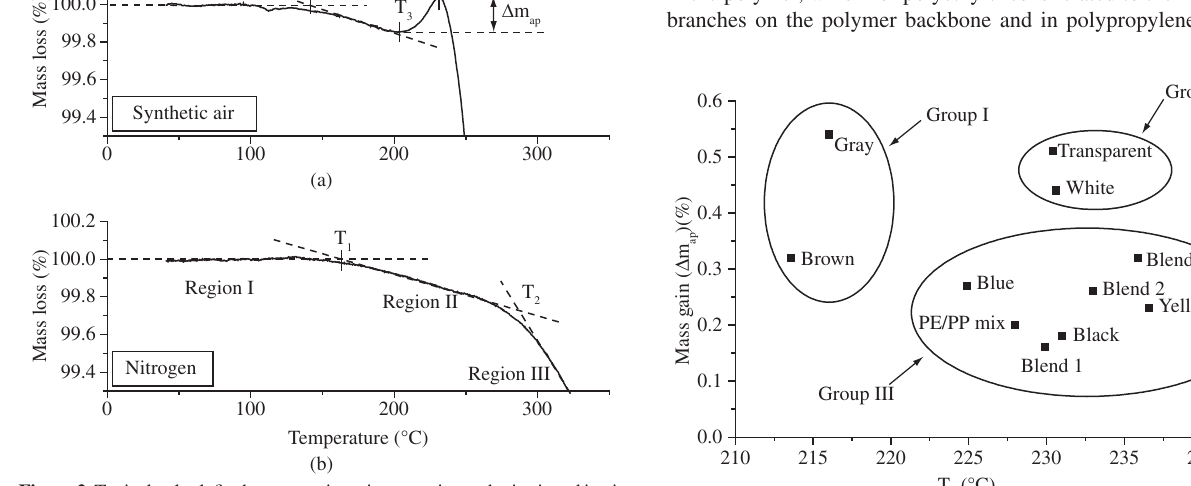
vs. T for all ap 4